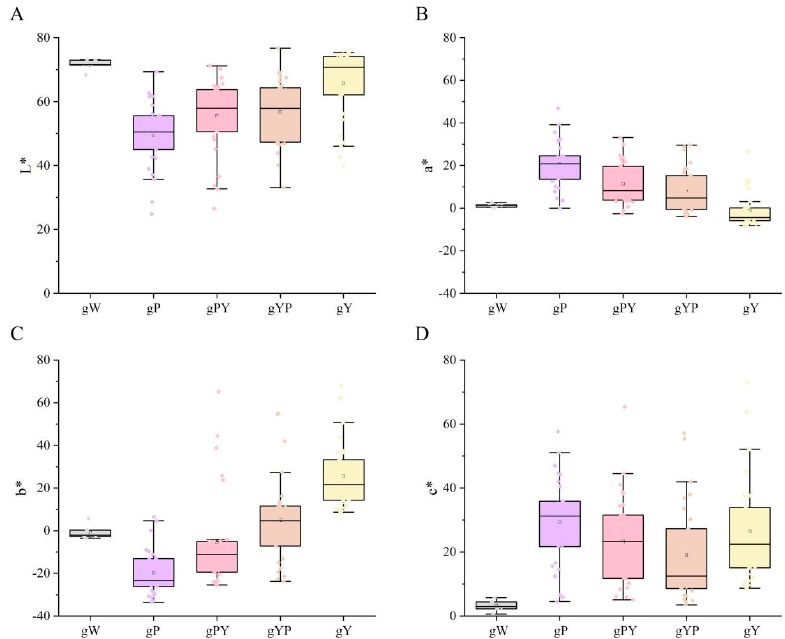
Figure 3. The box plot, based on flower color phenotype for Bletilla according to CIELab data. ( A ) L* (darkness to lightness), ( B ) a* (redness to greenness), ( C ) b* (yellowness to blueness), and ( D ) c* (Saturation). gW: White B. striata , gP: Pure purple group of B. striata , gPY: Purple perianth yellow lip group of B. striata , gYP: Purple perianth group of B. ochracea , gY: Pure yellow group of B. ochracea . In general, the purple family (gP, gPY, and gYP) had lower a L*, higher a*, and lower b* values. For the pure yellow gY, it had the highest L*, the lowest a*, and the highest b*. W had higher L* values, and the a* b* values tended to be close to zero. The 126 flower color data points in the a* b* hue coordinates were mainly violet, pink, and yellow, distributed in quadrants I, II, and IV on the a* and b* rectangular coordinate system. No distribution was observed in the blue–green quadrant III (Figure 4A). Flower color phenotype data, except for L2, were generally distributed along both sides of the fitted linear equation: Meanwhile, the L2 fitted linear equation was however, the linear regression fit level was insignificant. L2 was primarily concentrated in quadrant I, while other sites were mainly present in quadrants II and IV, indicating a difference between L2 and the other parts of the color distribution pattern (Figure 4B). Table 1. The distribution range of CIELab colorimetric values (L*, a*, b*, c*, and h) for different Bletilla groups. Group